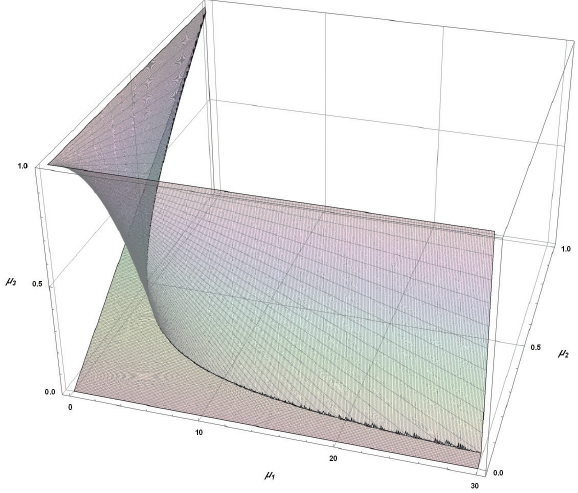
Figure 5 Definition area of the criterion space